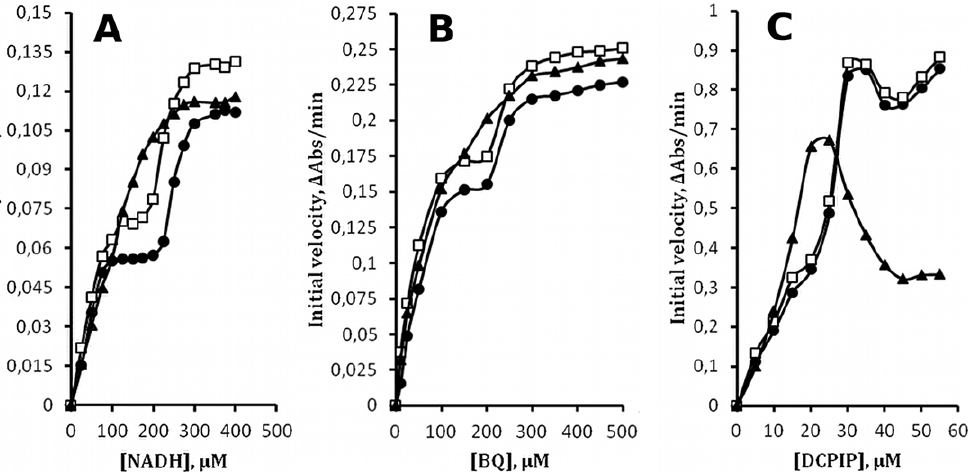
Figure 1. Steady-state kinetics. Initial velocity (see Methods) is plotted vs. substrate concentration. A. NADH at constant [BQ]=50 m M. B. BQ at constant [NADH]=50 m M. C. DCPIP at constant [NADH]=50 m M. Each plot depicts three temperature treatments of WrbA prior to assay (see text): squares, 5 u C; triangles, 23 u C; circles, 5 u C after 23 u C. Solid lines are intended only to guide the eye and do not represent fits to the data. doi:10.1371/journal.pone.0043902.g001 PLOS ONE |